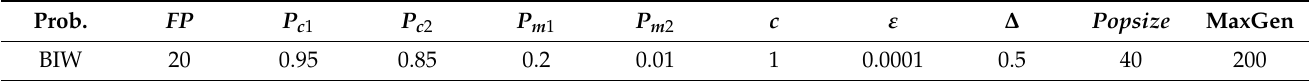
Table 10. The configurations of BIW